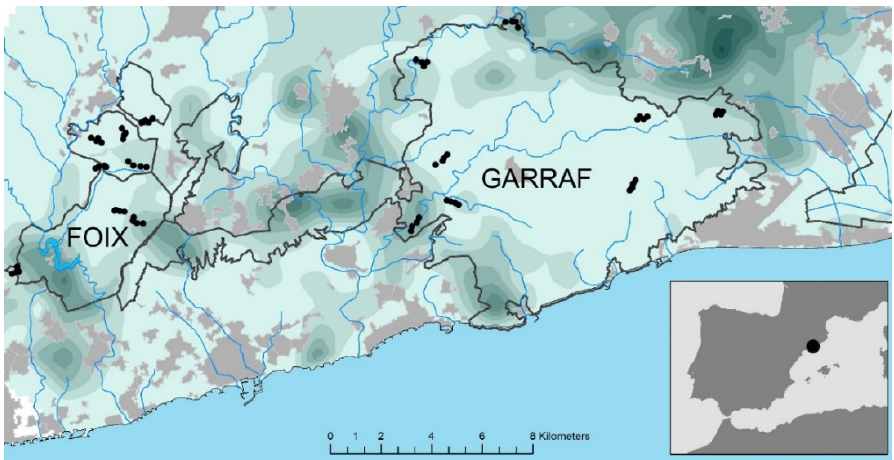
Figure 1. Situation of the 16 line-transects (four cameras each, black dots) in the natural parks of Garraf and Foix, Catalonia (NE Spain). Green dark isoclines indicate forest cover, and light grey urban areas.